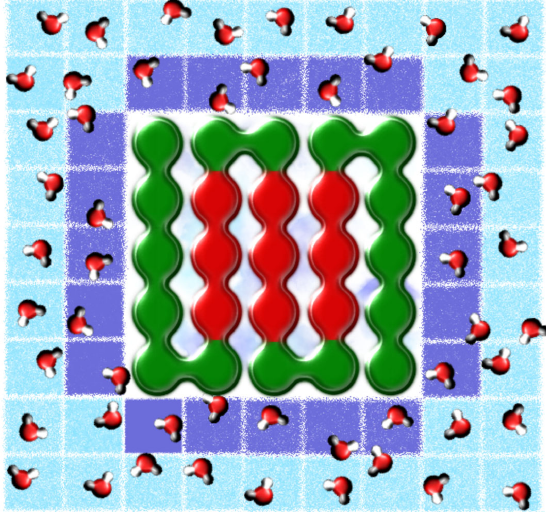
FIG. 10. Schematic representation of the water-protein model. The position of the water molecules is coarse-grained, assigning a cell to each water molecule. The cell size coincides with the average distance between first-neighbor molecules and fluctuates according to the Boltzmann weight of isobaric-isothermal ensemble. The conformational state of water molecule i is described via four bonding indices σ ij , each one accounting for the bonding conformation of molecule i with respect to the neighbor in the direction j . Water molecules around the protein form the hydration shell (dark blue cells). Protein is modeled as a self-avoiding lattice chain, composed of 20 different amino acids. Each amino acid can be hydrophobic or hydrophilic, according to the Kyte-Doolittle hydropathy scale [82]. Red and green amino acids in the figure refer to core and surface elements, respectively.